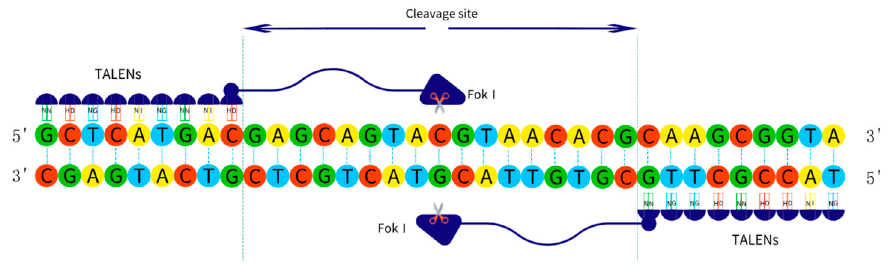
Figure 2. The schematic diagram of TALENs.